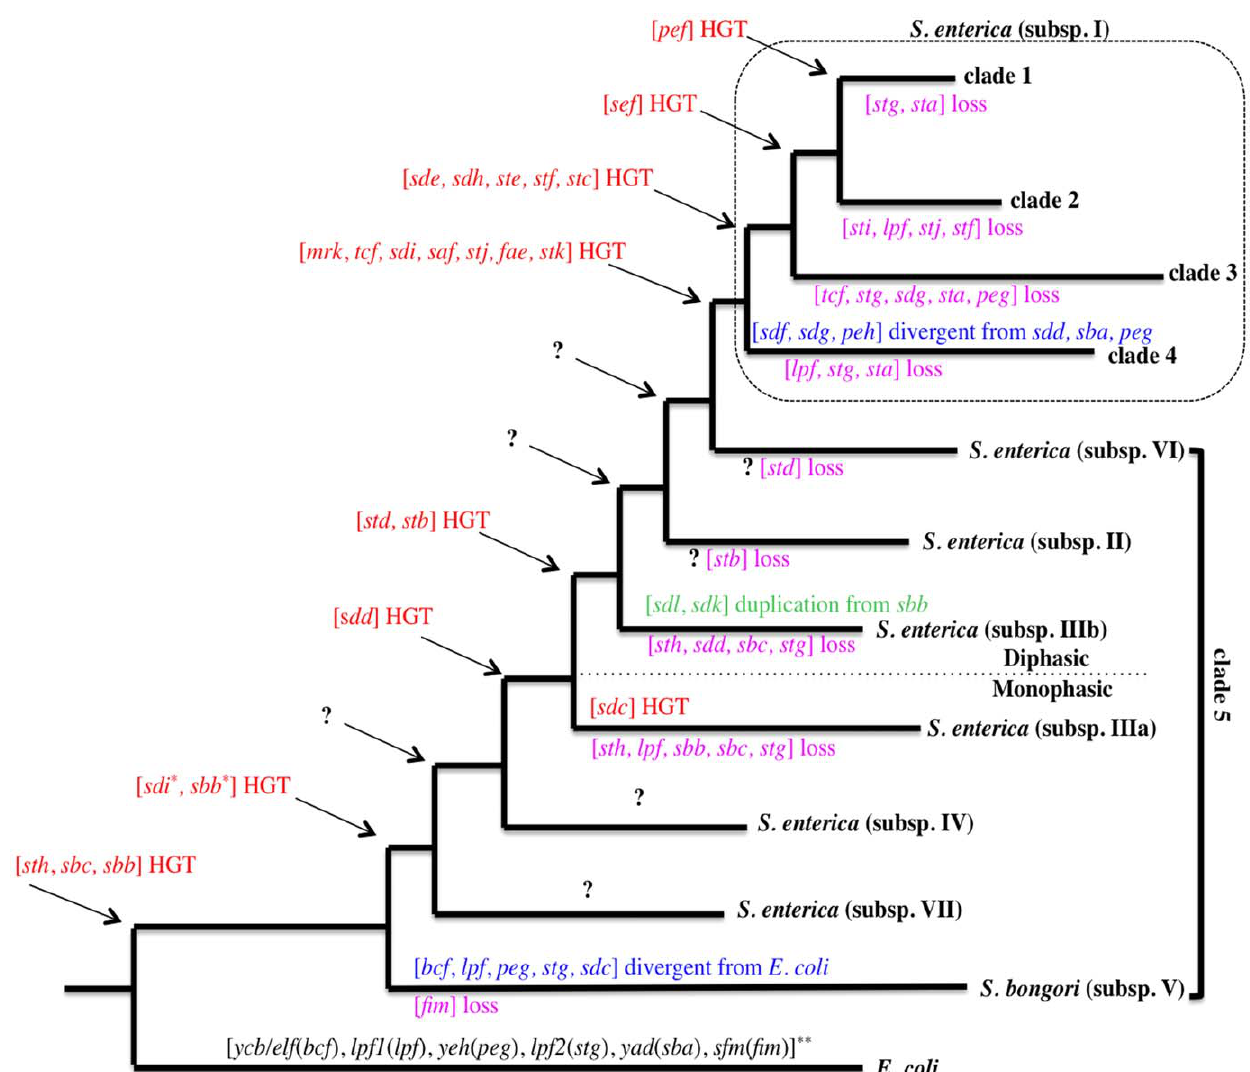
Figure 2. Salmonella and FGCs co-evolution model. Proposed tree that includes E. coli and the two Salmonella species, S. bongori and S. enterica, the latter being divided into seven subspecies (monophasic IIIa, IV, VII and diphasic I, VI, II, and IIIb; subsp. V is now S. bongori ). FGCs shown in red are suggested to have been acquired by HGT. FGCs shown in blue have diverged from orthologous E. coli or other Salmonella FGCs. In purple are FGCs that were lost. In green are FGCs that were duplicated. A dotted line separates the subspecies based on the presence of one or two flagellin genes. A dotted frame includes all the S. enterica subsp. I. The 5 clades correspond to the ones shown in Figure S3. The asterisks indicate that sdi and sbb were found in the integrative and conjugative element ICESe3 region of Salmonella enterica subsp. VII strain SARC16, suggesting independent acquisitions of these FGCs.